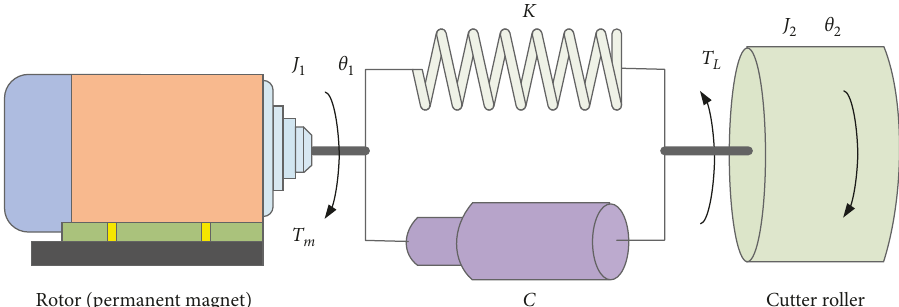
Figure 2: Electromechanical coupling torsional vibration physical model of cutting transmission